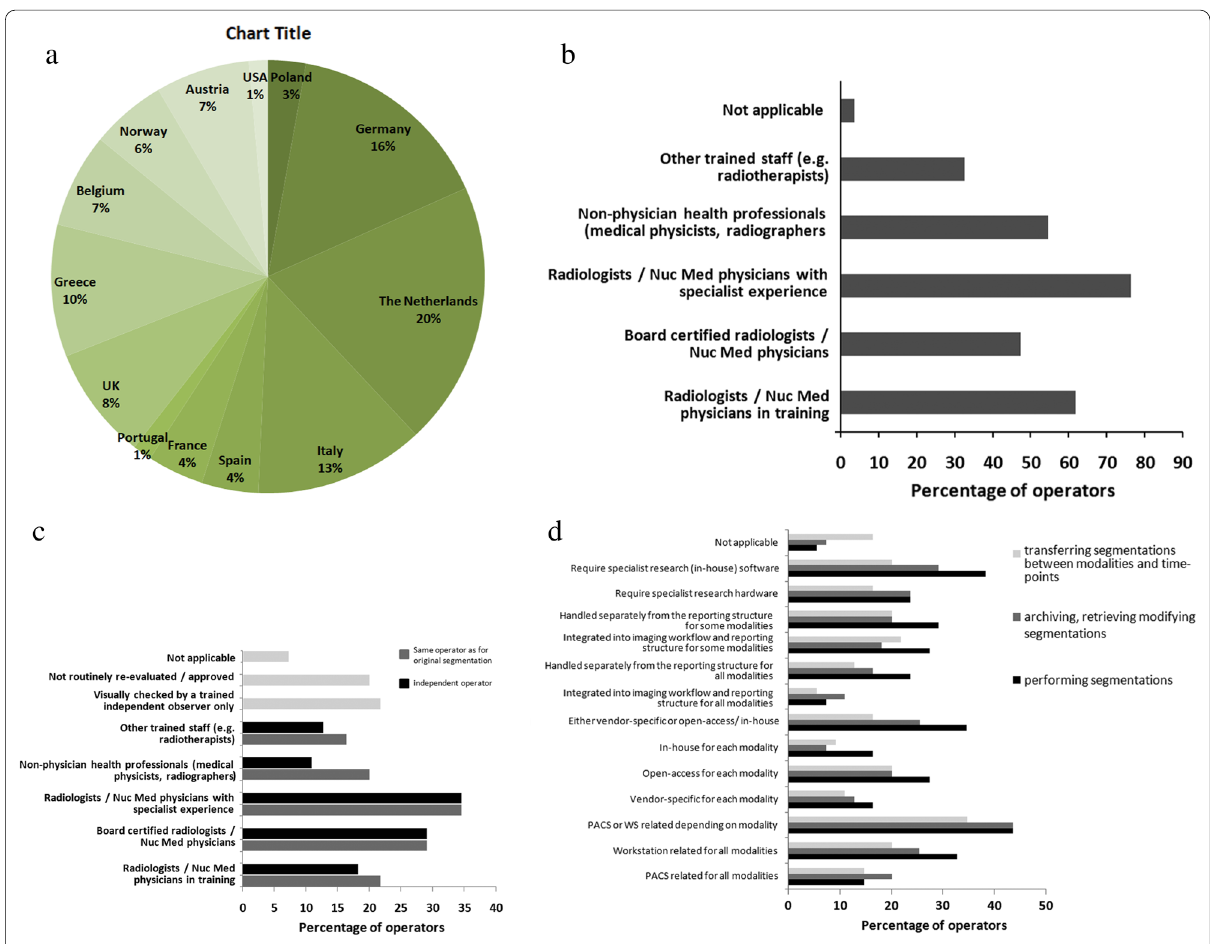
Fig. 2 Geographical distribution and experience of respondents to the mDelphi process, and respondents’ use of segmentation: The country of practice of the 58 respondents is given in ( a ). The category of skilled personnel performing segmentation and validating these segmentations in the respondents practice is given in ( b , c ), respectively. Tools used for performing the segmentation, archiving, retrieving, and modifying segmentations and for transferring and comparing segmentations between modalities and time points are shown in ( d